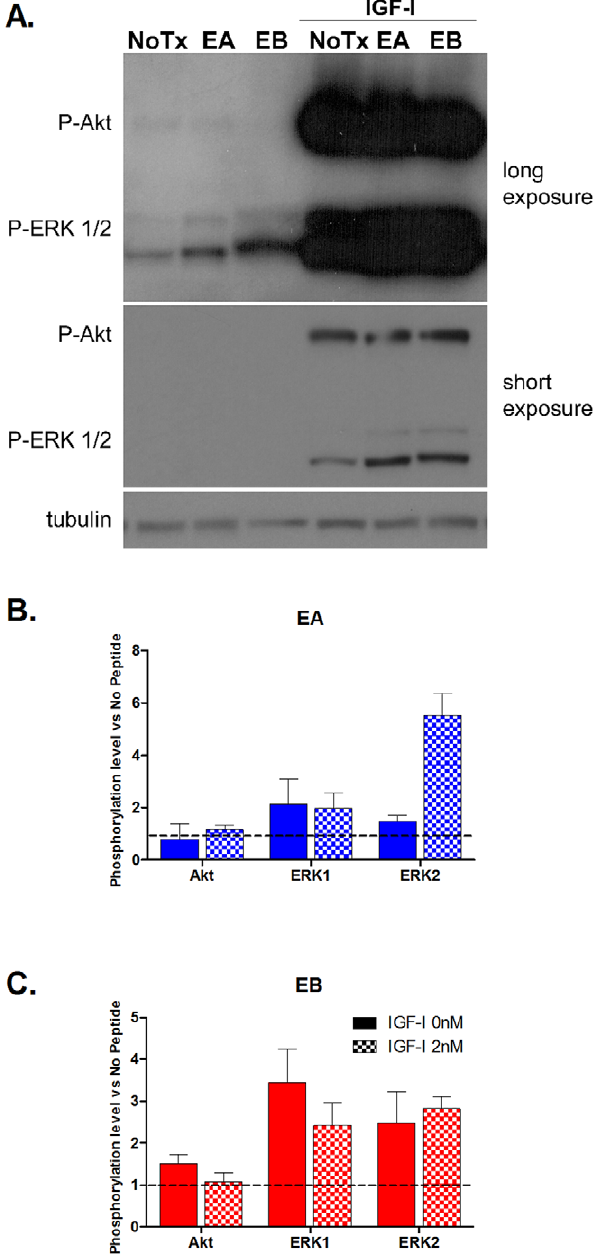
Figure 5. E-peptides affect IGF-IR downstream signaling. A–C . C2C12 cells were treated as in Figure 2, with 0 nM or 2 nM IGF-I and optimal doses of the E-peptides (EA 1 m M, EB 10 nM) for 20 minutes. B– C . Quantification of Akt and ERK1/2 phosphorylation after EA (B) or EB (C) treatment. EA and EB alone are compared to NoTx, while IGF-I with E-peptides are compared to 2 nM IGF-I alone. Data are presented as the effect on phosphorylation after E-peptide treatment compared to NoTx or NoPeptide plus IGF-I. Bars represent means 6 s.e.m. of N=3–4 replicates. { , p , 0.05 for comparisons of 0 nM IGF samples to their 2 nM IGF-I counterparts via student